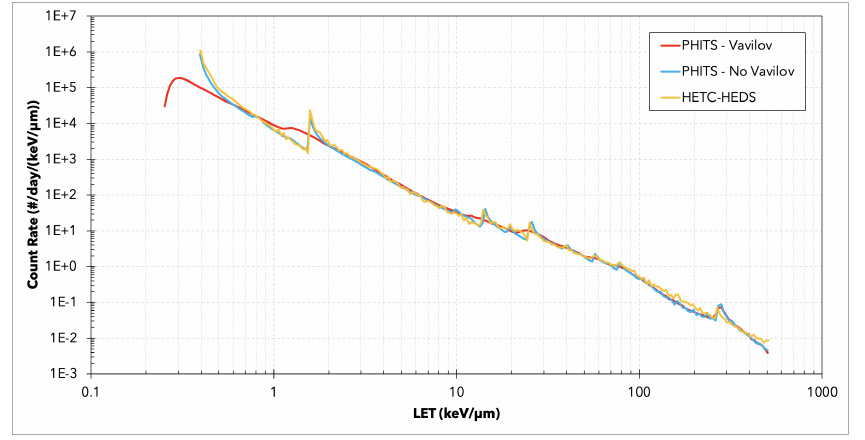
Figure 4. A comparison between the LET spectra in D6 obtained from HETC-HEDS and PHITS with and without Vavilov energy